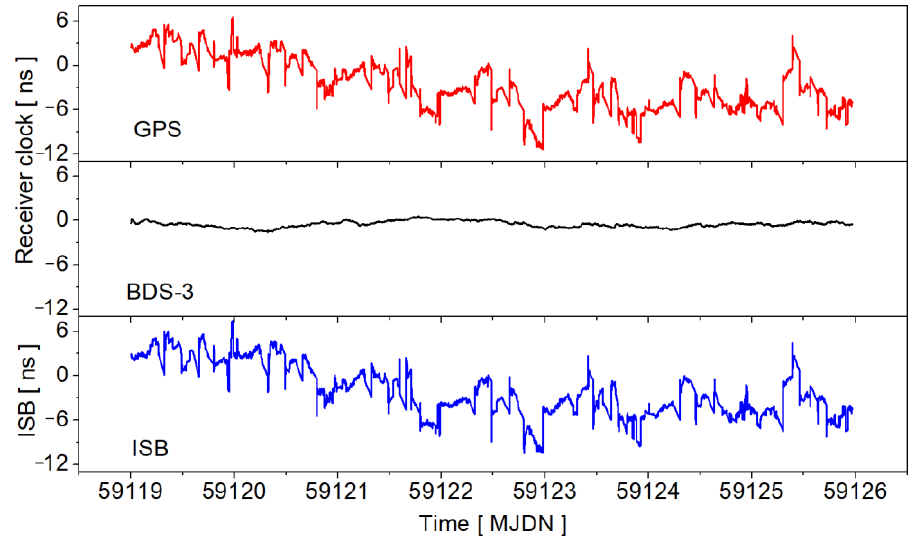
Figure 8. Receiver clock and ISB series of station lck4, the top, middle, and bottom panels represent GPS receiver clock, BDS-3 receiver clock, and ISB, respectively.